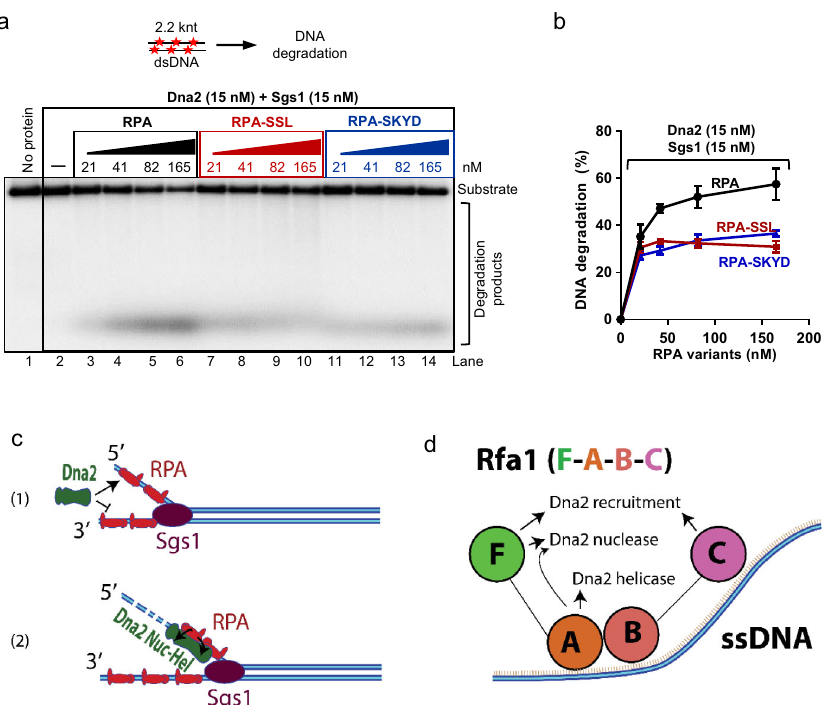
Fig. 7 RPA-SSL and SKYD mutants are impaired in DNA end resection. a A representative experiment to monitor DNA end resection by Sgs1, Dna2, and increasing concentrations of yeast RPA variants using 2.2-knt-long dsDNA (0.5 nM, in molecules). The reaction buffer contained 100 mM NaCl. Red asterisks indicate random radioactive labels on the DNA. b Quanti fi cation of overall substrate utilization from experiments such as shown in panel a . Error bars, SEM; n = 3. c A model showing that RPA fi rst recruits Dna2 to 5 ′ -overhanged DNA (1). Subsequently, RPA remains a component of the nucleoprotein complex and stimulates both nuclease (Nuc) and ATPase-driven translocase (Hel) activities of Dna2 (2). d A model depicting domains of the RPA large subunit, Rfa1, and their involvement in ssDNA binding, recruitment of Dna2 and stimulation of nuclease and helicase activities of Dna2,